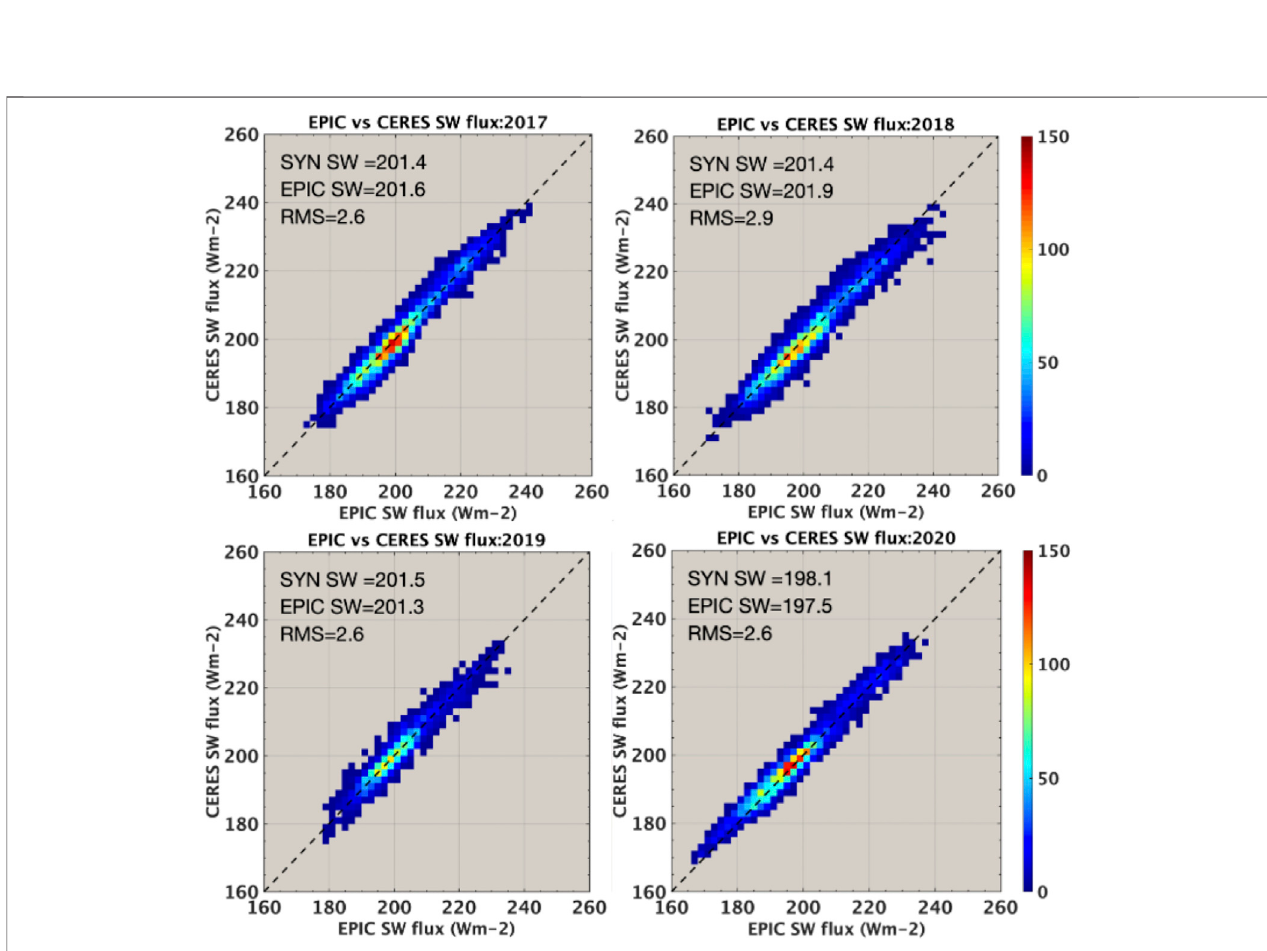
FIGURE 13 | Comparison of coincident hourly SW fl uxes from EPIC and CERES SYN1deg for 2017 – 2020.